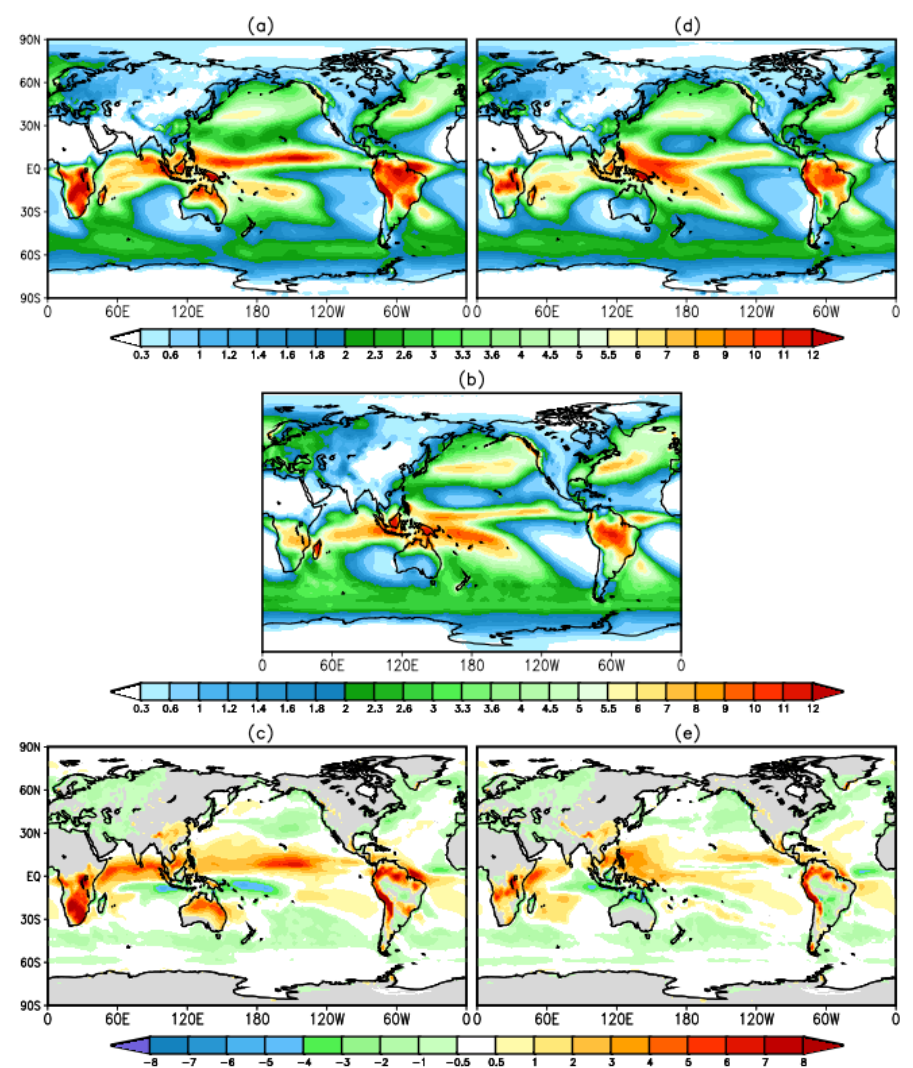
Figure 12. December-January-February total precipitation in mmday − 1 from (a) experiment 6 (MERRA AGCM-like), (b) GPCP, (c) the difference of experiment 6 minus GPCP, (d) experiment 5 (MERRA2 AGCM-like), (e) the difference of experiment 5 minus GPCP. The gray shading indicates land